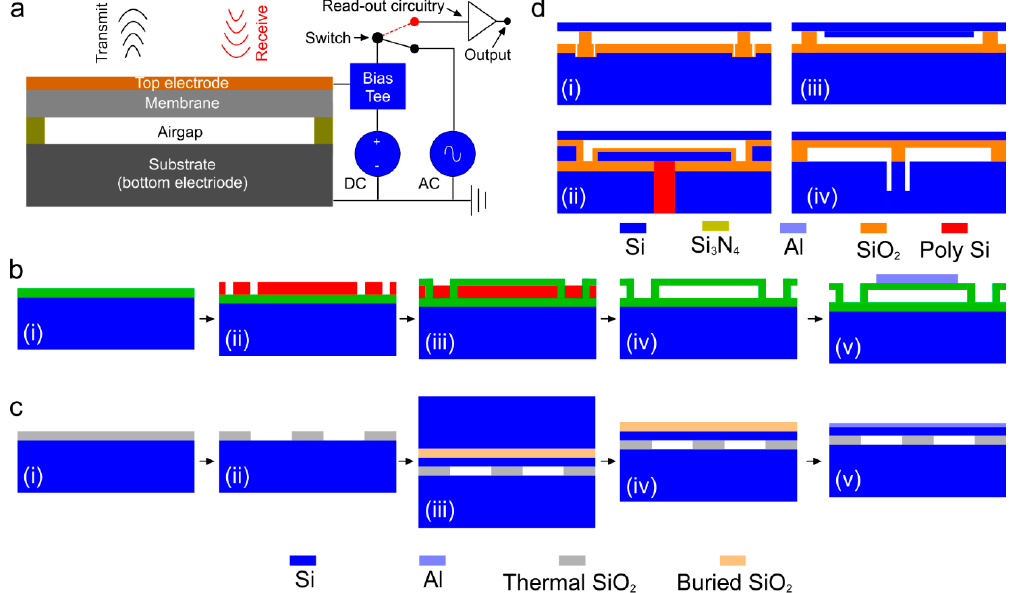
Figure 2. Capacitive micromachined ultrasonic transducer (CMUT) technology. ( a ) Schematic of a cross-section of a CMUT and its working principle, ( b ) steps of sacrificial release process: (i) substrate and insulation layer realization, (ii) sacrificial layer deposition and pattern, (iii) membrane layer deposition, (iv) sacrificial layer release, and (v) top electrode deposition, ( c ) steps of wafer bonding process: (i) thermal oxidation of silicon wafer (substrate), (ii) gap height and shape realization, (iii) bonding between silicon on insulator (SOI) and oxidized silicon wafer, (iv) thick silicon wafer etching, (v) buried oxide layer etching and top electrode realization [112], and ( d ) other CMUT designs fabricated using: (i) local oxidation of silicon (LOCOS) process [113], (ii) thick-buried-oxide process [114–117], (iii) mechanically coupled plate to the membrane [118], (iv) compliant post structure [114]. Reproduced with permission from [46].